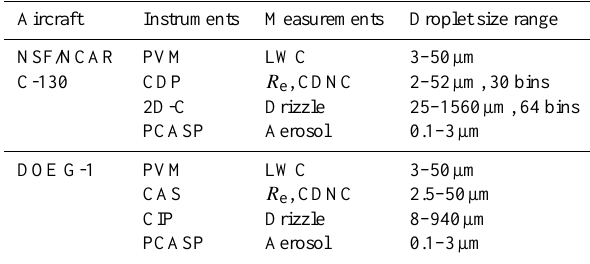
Table 1. Airborne instruments and